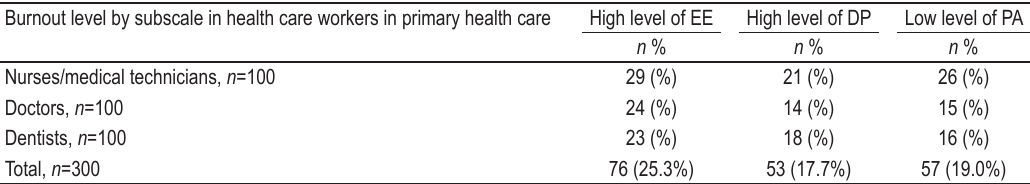
TABLE 1. Burnout level by subscale in nurses/medical technicians, doctors, and dentists Burnout level by subscale in health care workers in primary health care High level of EE High level of DP Low level of